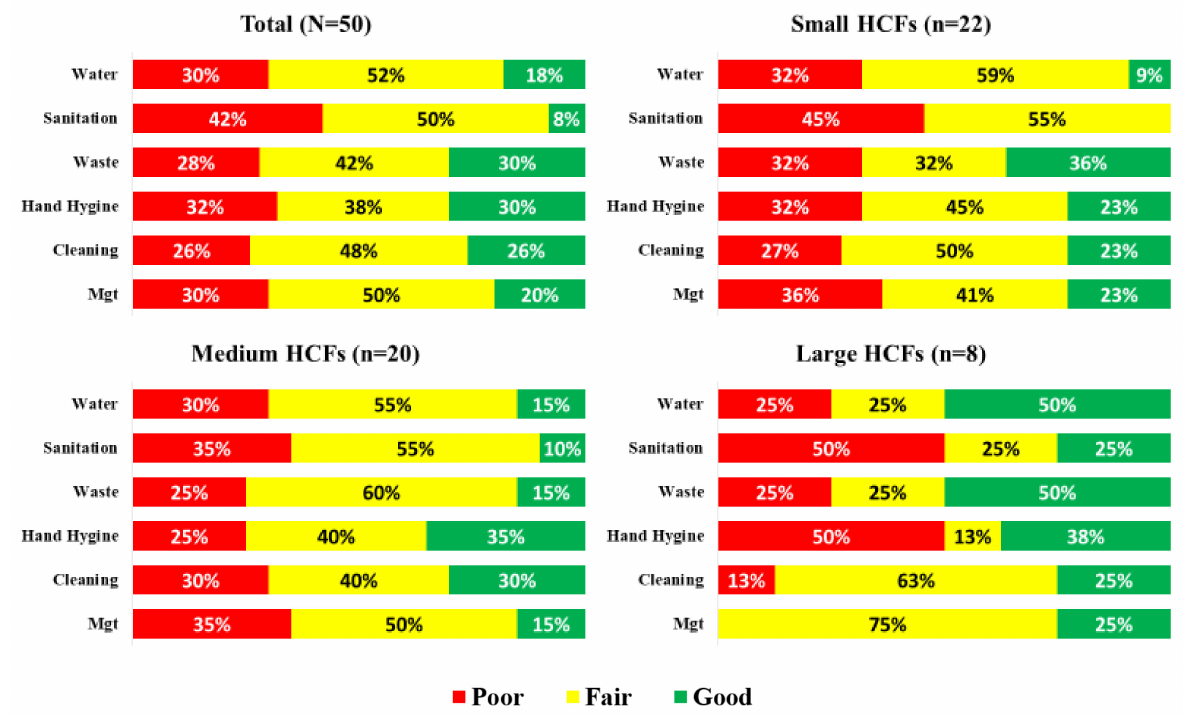
Figure 2. Proportion of HCFs with poor, fair, and good WASH service coverage by the size of